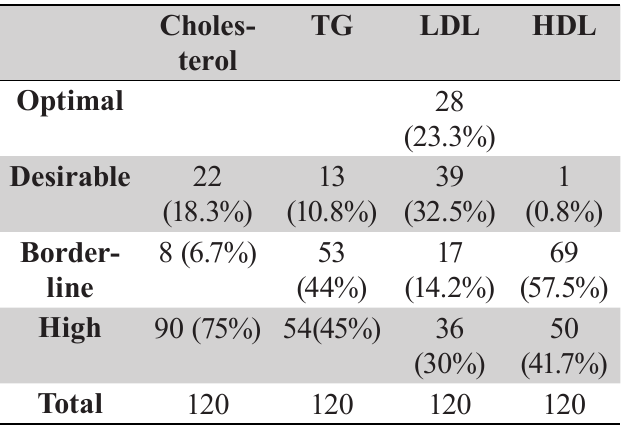
Table 3. Lipid profile level in DM patients.